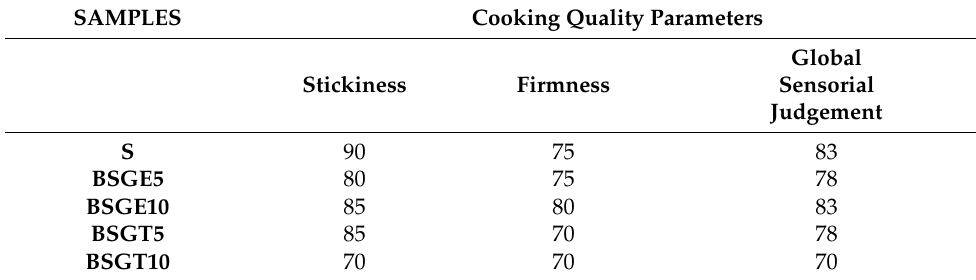
Table 4. Sensory evaluation of pasta